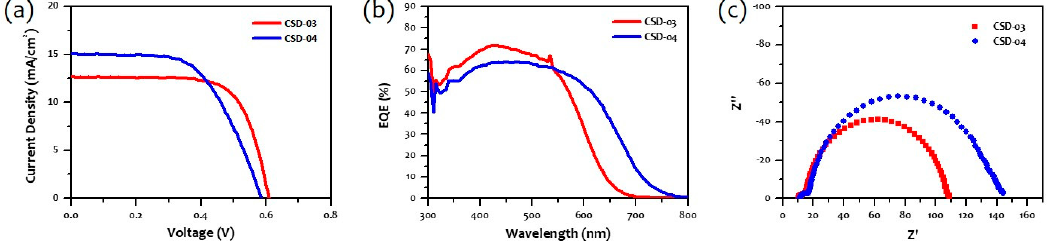
Figure 4. ( a ) Current density-voltage (J – V) characteristics, ( b ) incident photon-to-current efficiency (IPCE) spectra, and ( c ) Nyquist plots in the dark of the masked dye-sensitized solar cells (DSSCs) fabricated with CSD-03 and CSD-04 . Table 2. Masked DSSC (5 µ m-thick TiO 2 ) performance parameters of CSD-03 , CSD-04 , and N719 . Dyes (Soaking Time) V oc (V)